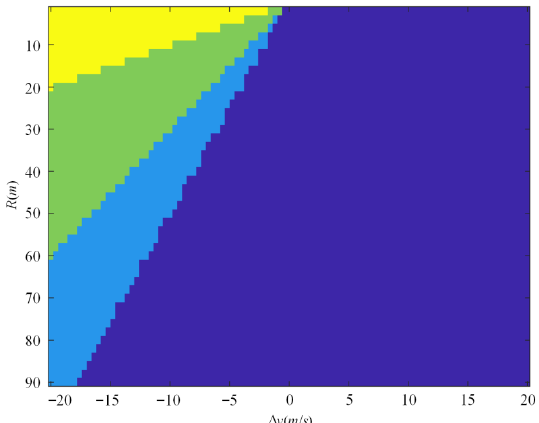
Figure 7. The boundaries of the two-dimensional ISSD according to TTC.